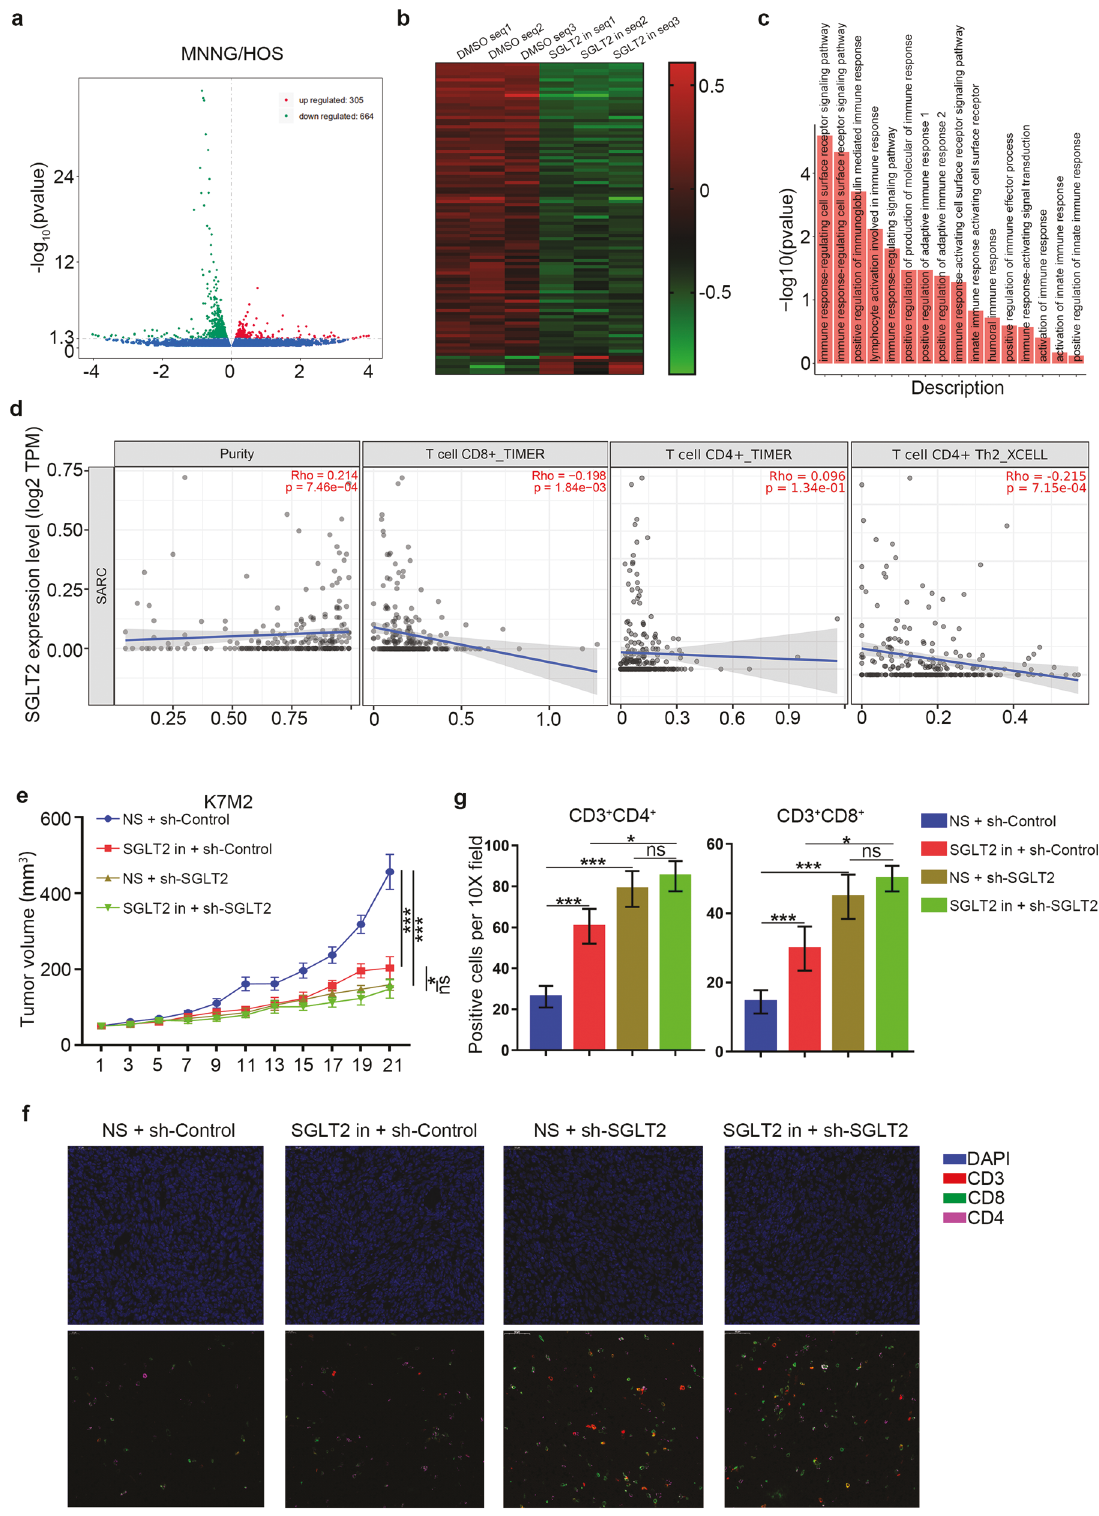
Fig. 3 Inhibition of osteosarcoma progression due to the induction of immune cell in fi ltration by the SGLT2 inhibitor. MNNG/HOS cells treated with or without SGLT2 inhibitor (canagli fl ozin, 1 uM) for 24 h were harvested for RNA sequencing analysis, and Volcano plot ( a ) and heatmap ( b ) showed the differentially expressed genes in MNNG/HOS cells treated with or without SGLT2 inhibitor. Green points represent downregulated genes, while red points represent upregulated genes. c Histogram of the GO-enriched pathways related with immune in fi ltration in the SGLT2 inhibitor treatment group. d TIMER web tool was used to search the relationship of the mRNA expression level of SGLT2 and the in fi ltration level of CD8 + T cells, CD4 + T cells, and CD4 + Th2 cells in osteosarcoma. e K7M2 tumor growth curves ( n = 5/group) of different groups (*** p < 0.001). NS normal saline. f , g Immuno fl uorescence staining analysis of the percentage of CD3 + CD4 + and CD3 + CD8 + T cells in fi ltrated in K7M2 tumors ( f ). Data are presented as the mean ± SD ( g , n = 5/group, *** p < 0.001). Cell Death and Disease (2022)